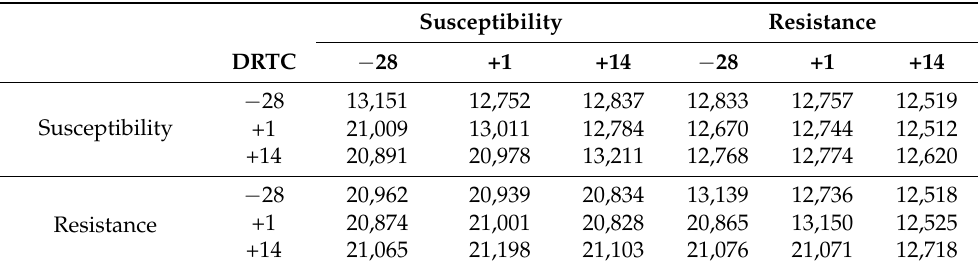
Table 1. The numbers of genes tested within days relative to calving (DRTC; diagonal) that were shared within and across comparison of clusters 1 .